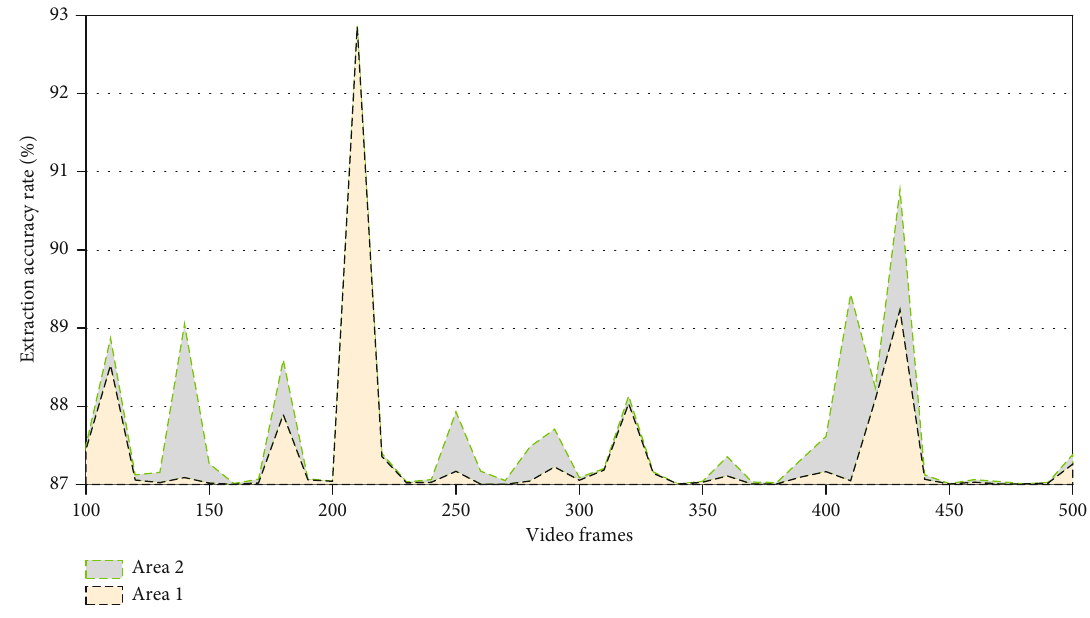
Figure 5: Accuracy rate of regional optimal solution extraction/%. Table 2: Experimental software and hardware platform. RAM 8GB Programming